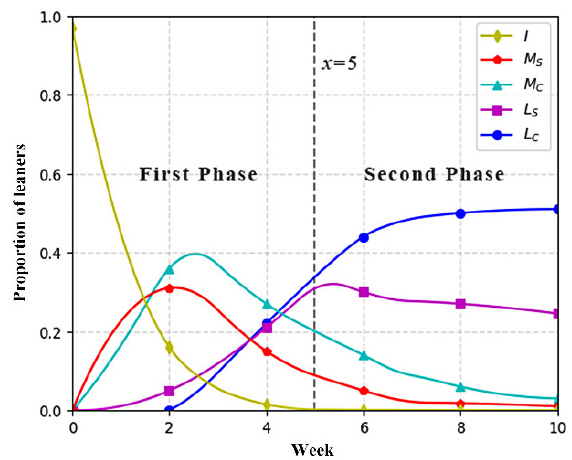
Figure 7. Collaborative state of experimental group.